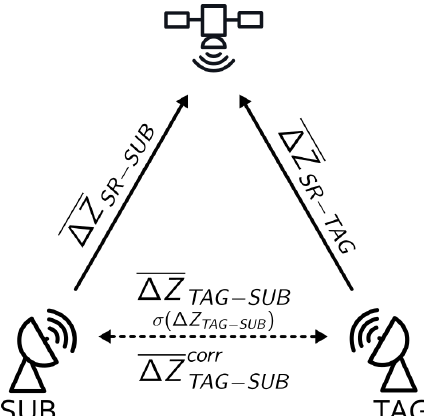
Figure 2. Schematic diagram of the SR–GR calibration bias esti- mation and GR–GR intercomparison. The SUB and TAG calibra- tion biases ( (cid:49)Z SR-SUB and (cid:49)Z SR-TAG , respectively) are calculated with respect to SR and used to correct the ground radar reflectivities. The mean difference between SUB and TAG radars are calculated before ( (cid:49)Z TAG-SUB ) and after bias correction ( (cid:49)Z